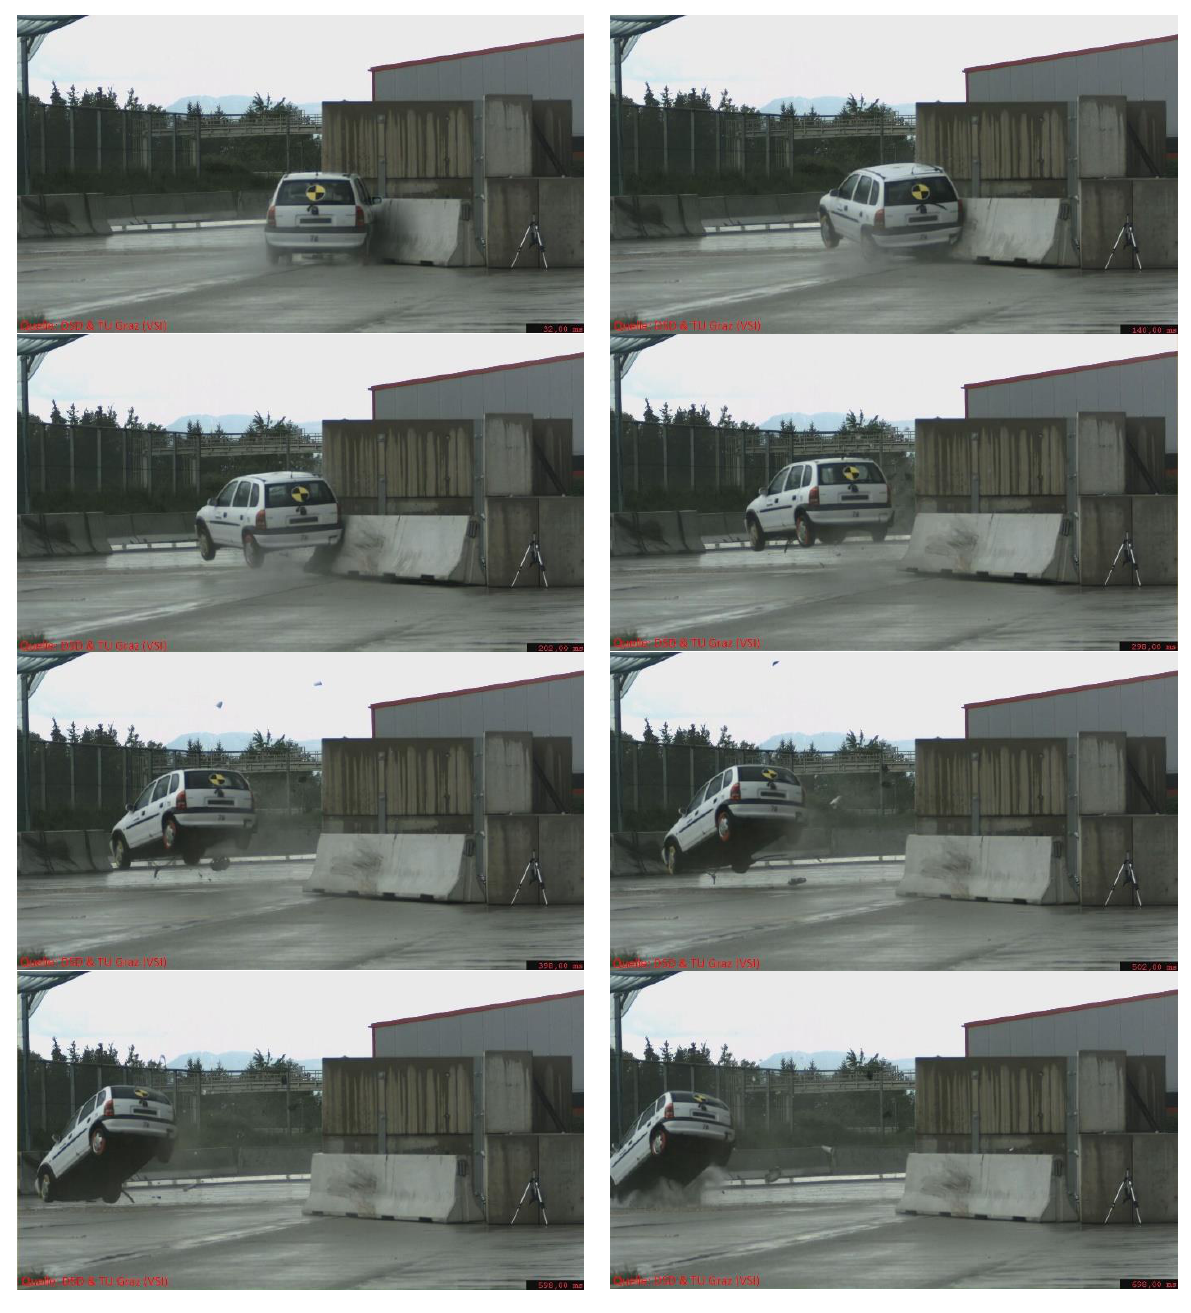
Figure 9. Vehicle motion impacting a 8 m concrete barrier. The vehicle impacted the barrier and was deflected upwards. The vehicle was rotated to the y-axis (pitching) and the rear wheels had a height of approximately 1.0 m.